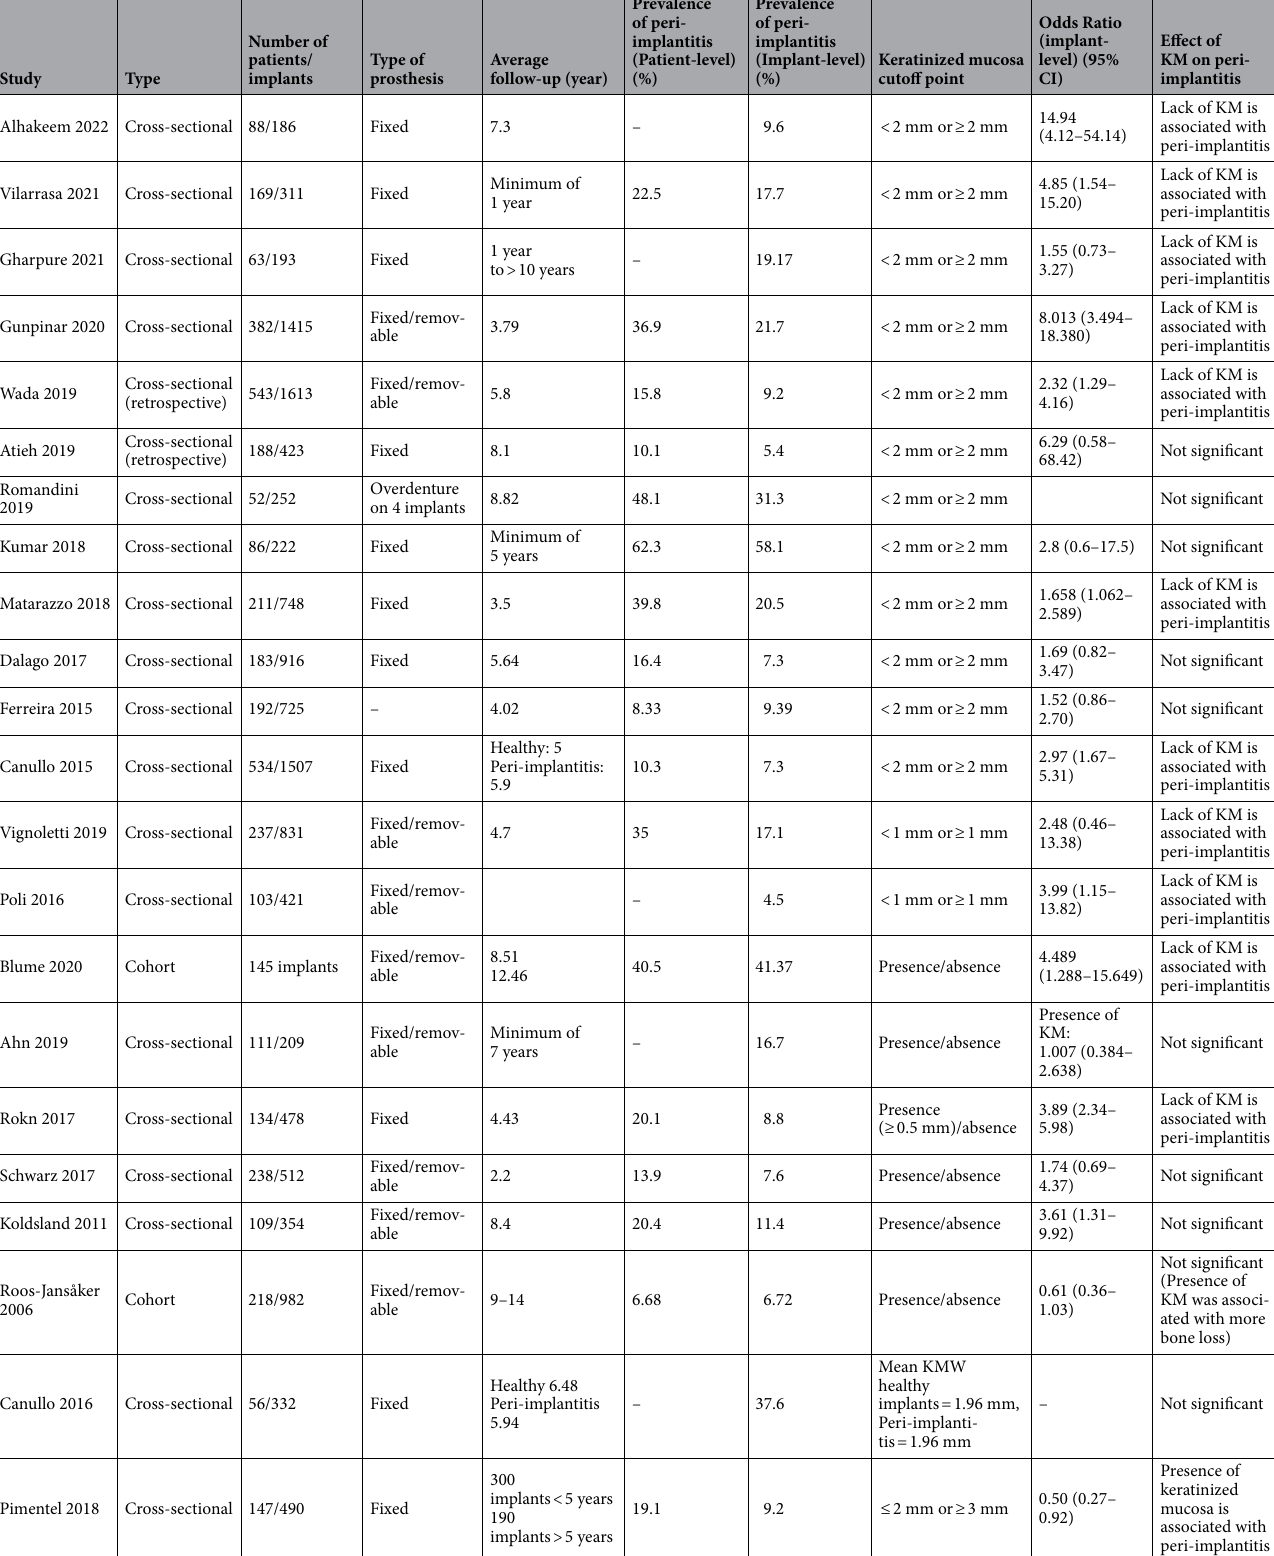
Table 1. Characteristics of the included studies in this systematic review. KM: keratinized